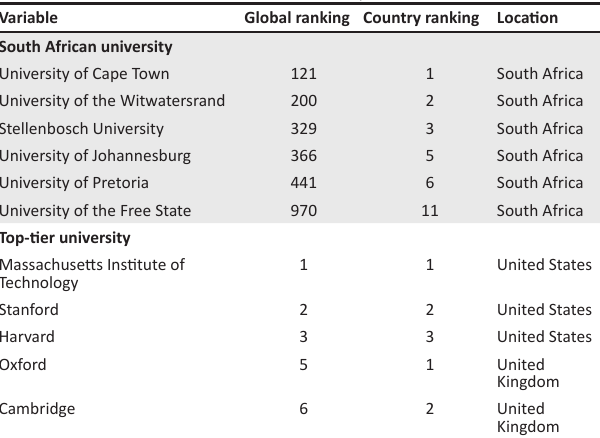
TABLE 1: Selected universities used for the